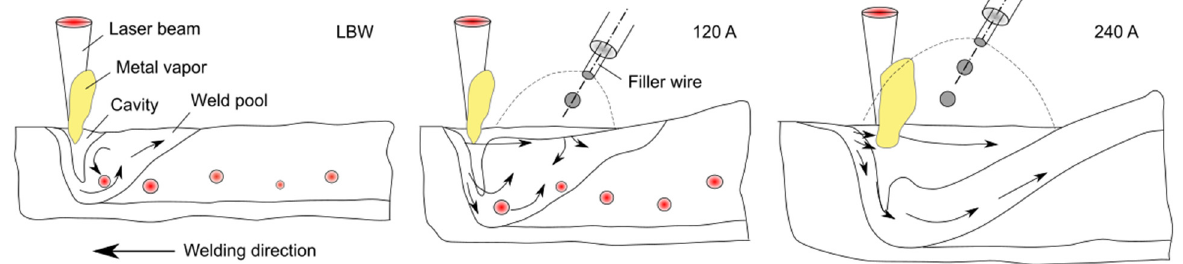
Figure 18. Effect of welding current on porosity in LAHW of 3 mm AA5052 aluminium based on X-ray transmission during real-time observation. Redrawn from [90,262].